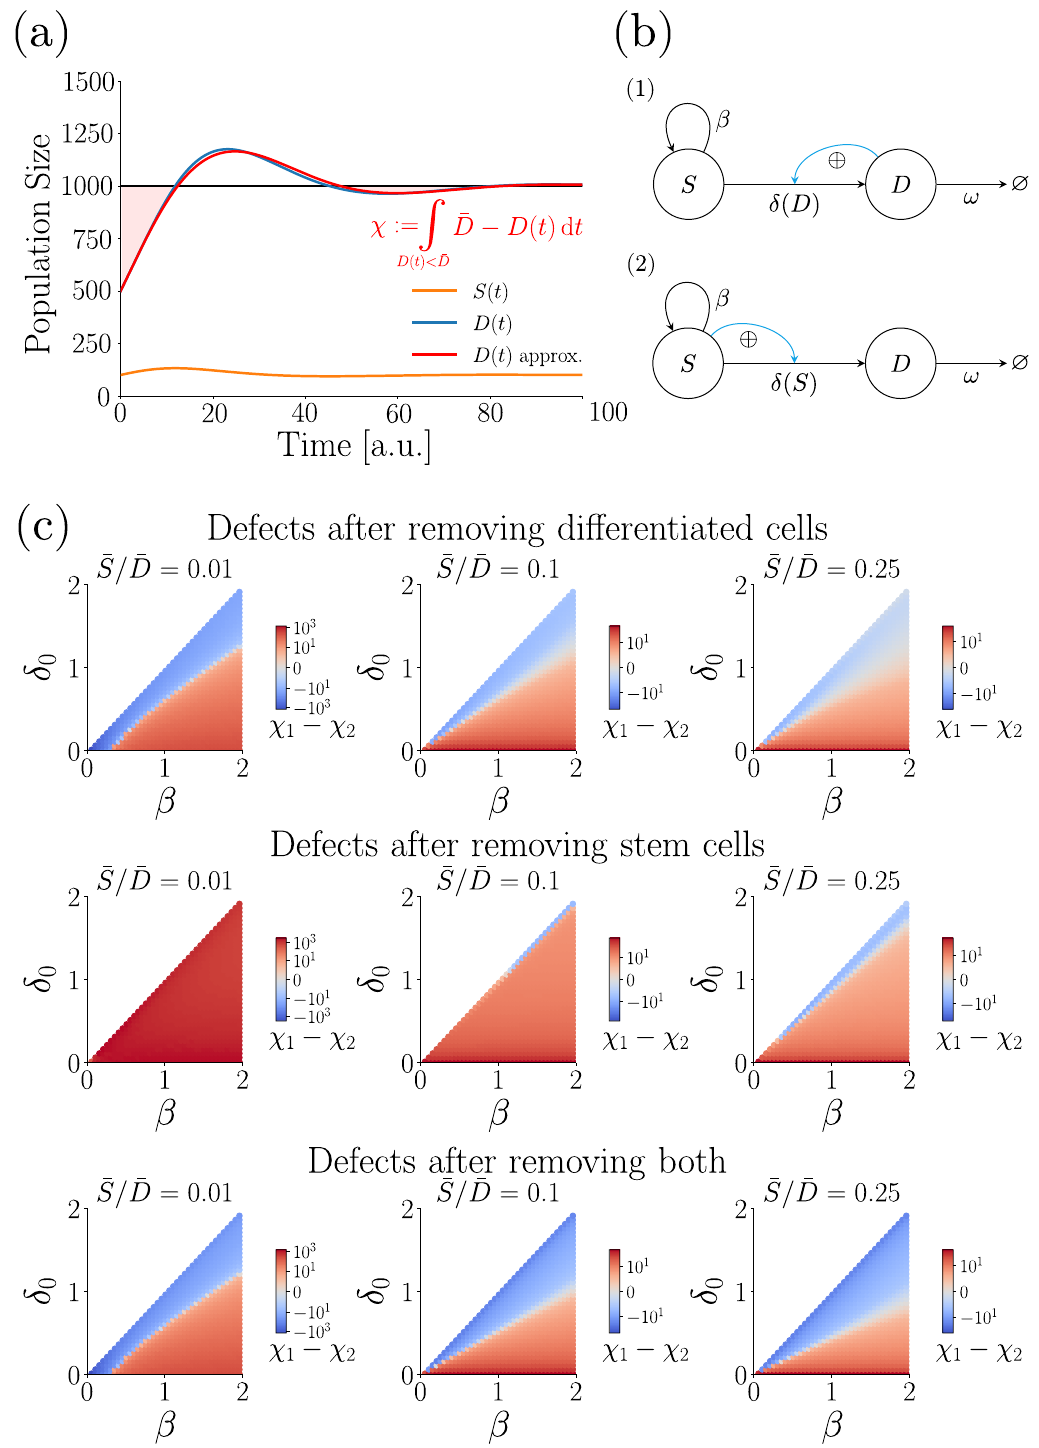
Figure 3. (a) Illustration of our model comparison: After a perturbation at t = 0 , the model relaxes to its steady state (continuous blue and orange lines, depicting differentiated and stem cells, respectively). We use a first- order approximation (continuous red line) to not have to rely on costly numerical solutions of the system, and compute the ’defects’ χ of the models we want to compare (shaded red area). (b) The two models we compare in this figure. Top: model 1, where stem cell differentiation is stimulated by the differentiated cell compartment; bottom: model 2, where the stem cell compartment stimulates its own differentiation. Note that model 1 is equivalent to our basic colon epithelium model derived earlier. (c) Difference in defects of model 2 and 1 throughout the parameter space. Areas shaded in red depict regions where model 1 shows a bigger defect than the alternative model; blue areas indicate the opposite. Columns represent different cases of stem cell fraction at steady state (1, 10, and 25% respectively), rows represent the three different kinds of perturbations (removing differentiated cells, removing stem cells, and removing both,